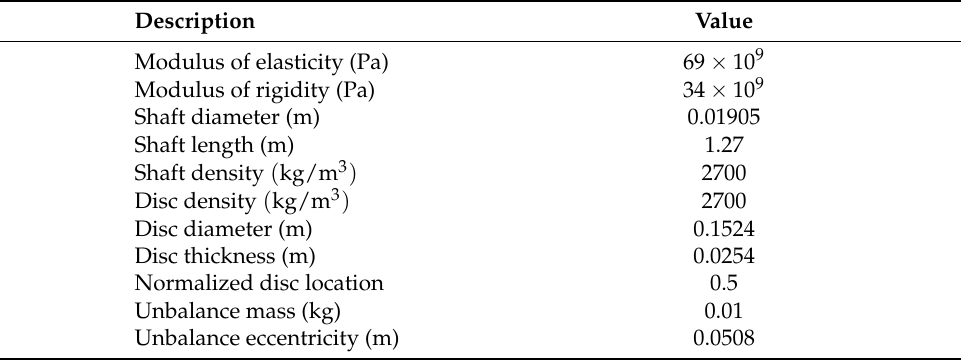
Table 1. Material properties and dimensions of the shaft–disc